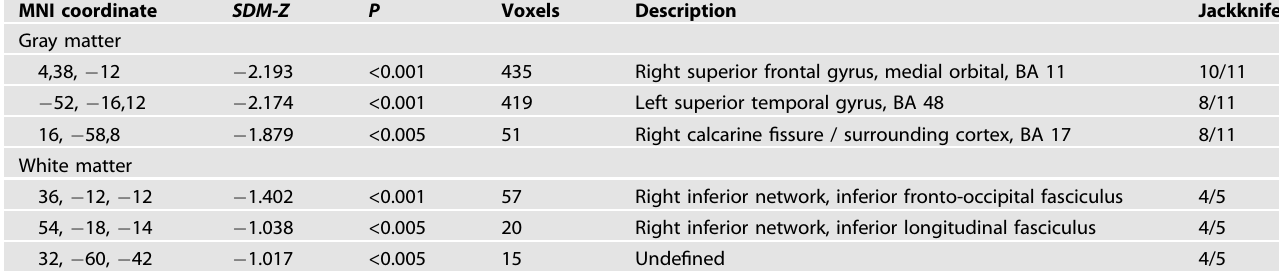
Table 2. Signi fi cant decreased GM and WM in patients with T2DM-CD compared with HCs.